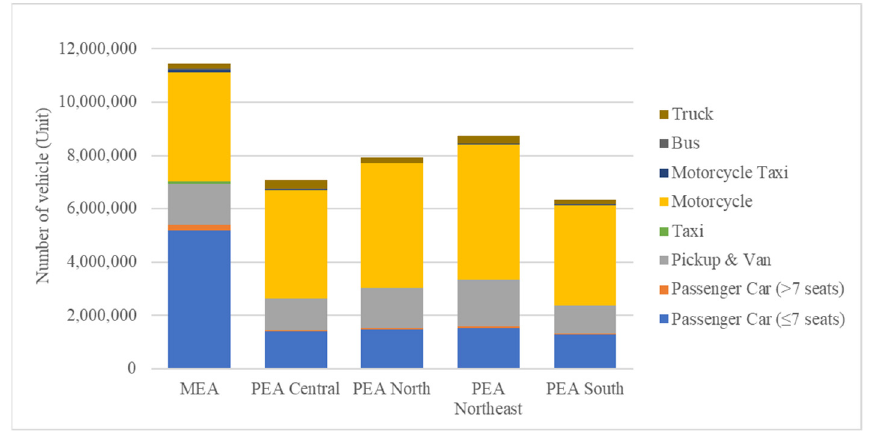
Figure 6. Number of vehicles of each type. Table 1. Proportion of number of vehicles in each area.